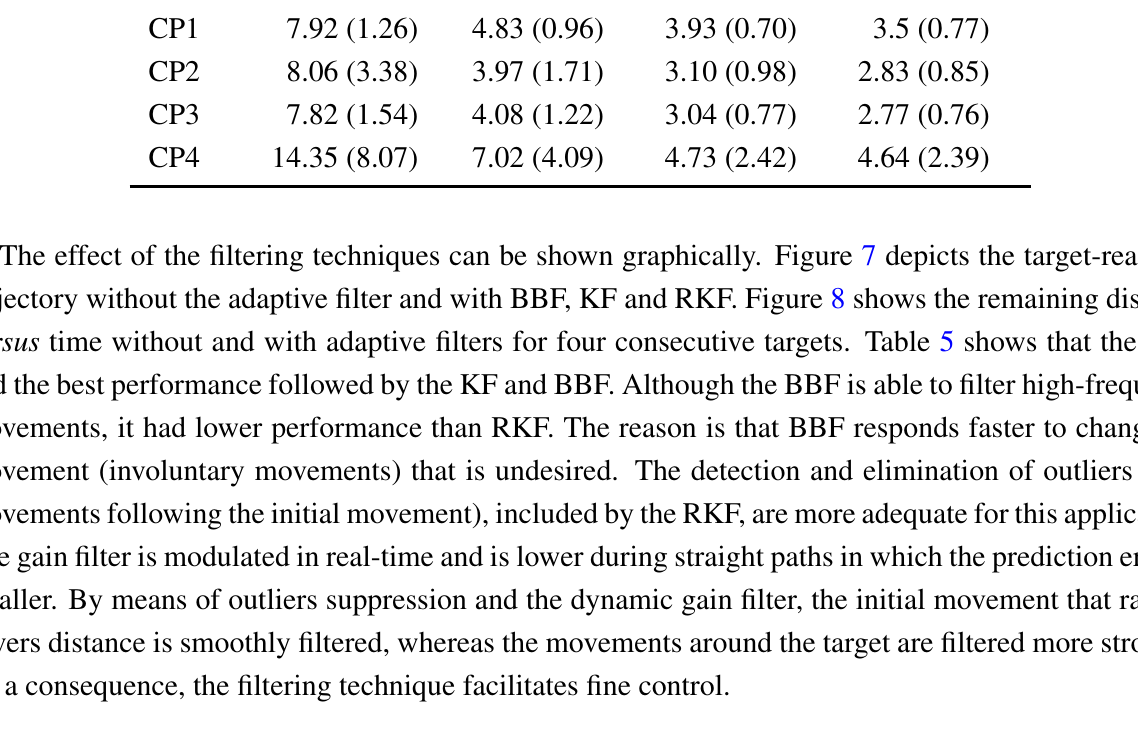
Figure 7. Pointer path performed by CP1 to move the cursor from a target (green circle) to the next target (blue circle). ( a ) without filtering ( b ) with BBF ( c ) with KF ( d ) with